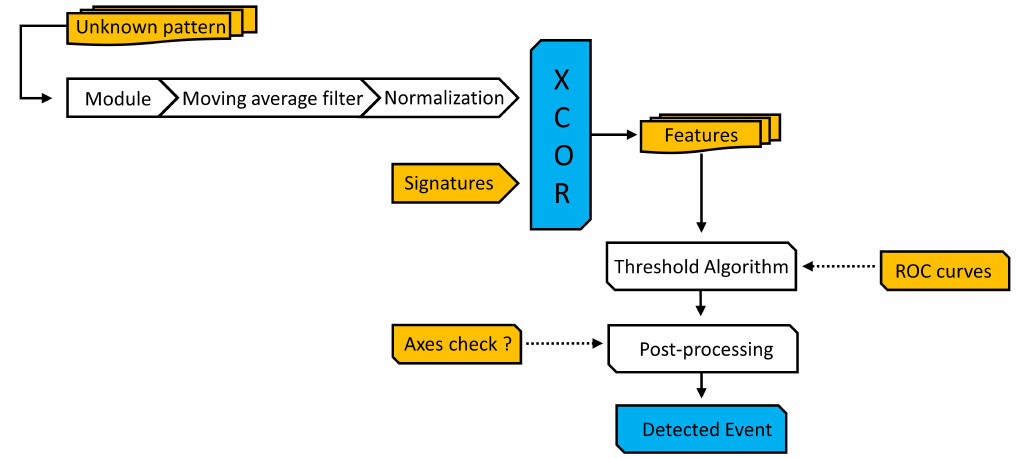
Figure 1. Paradigm adopted for the sake of events